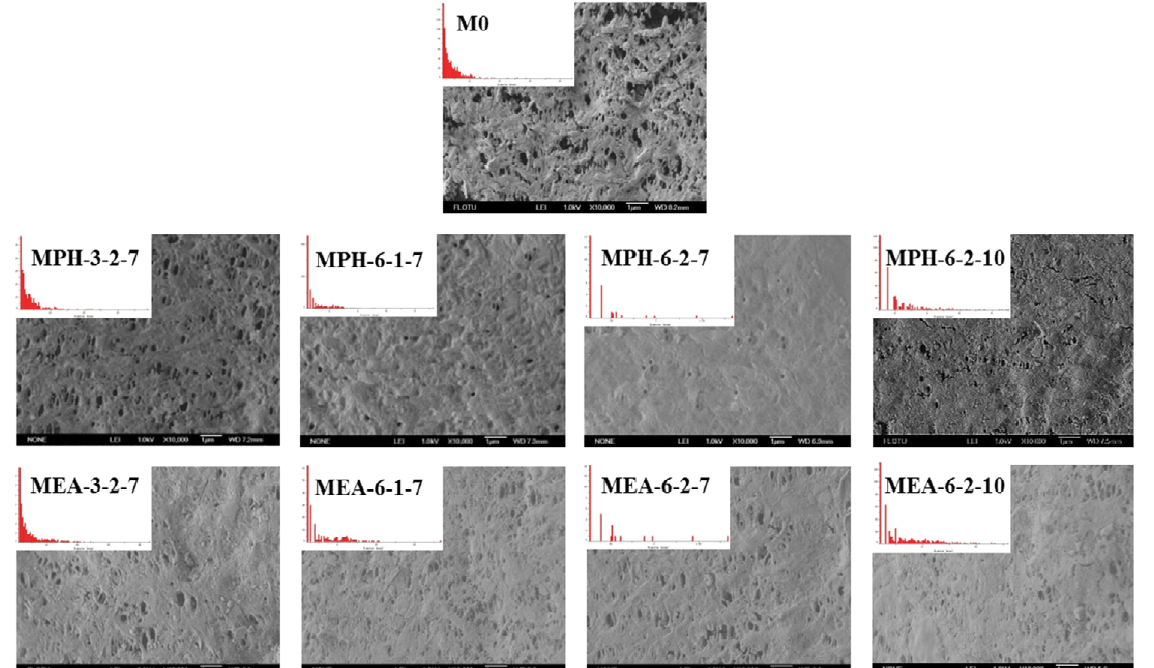
Figure 3. SEM images and pore size distribution of various